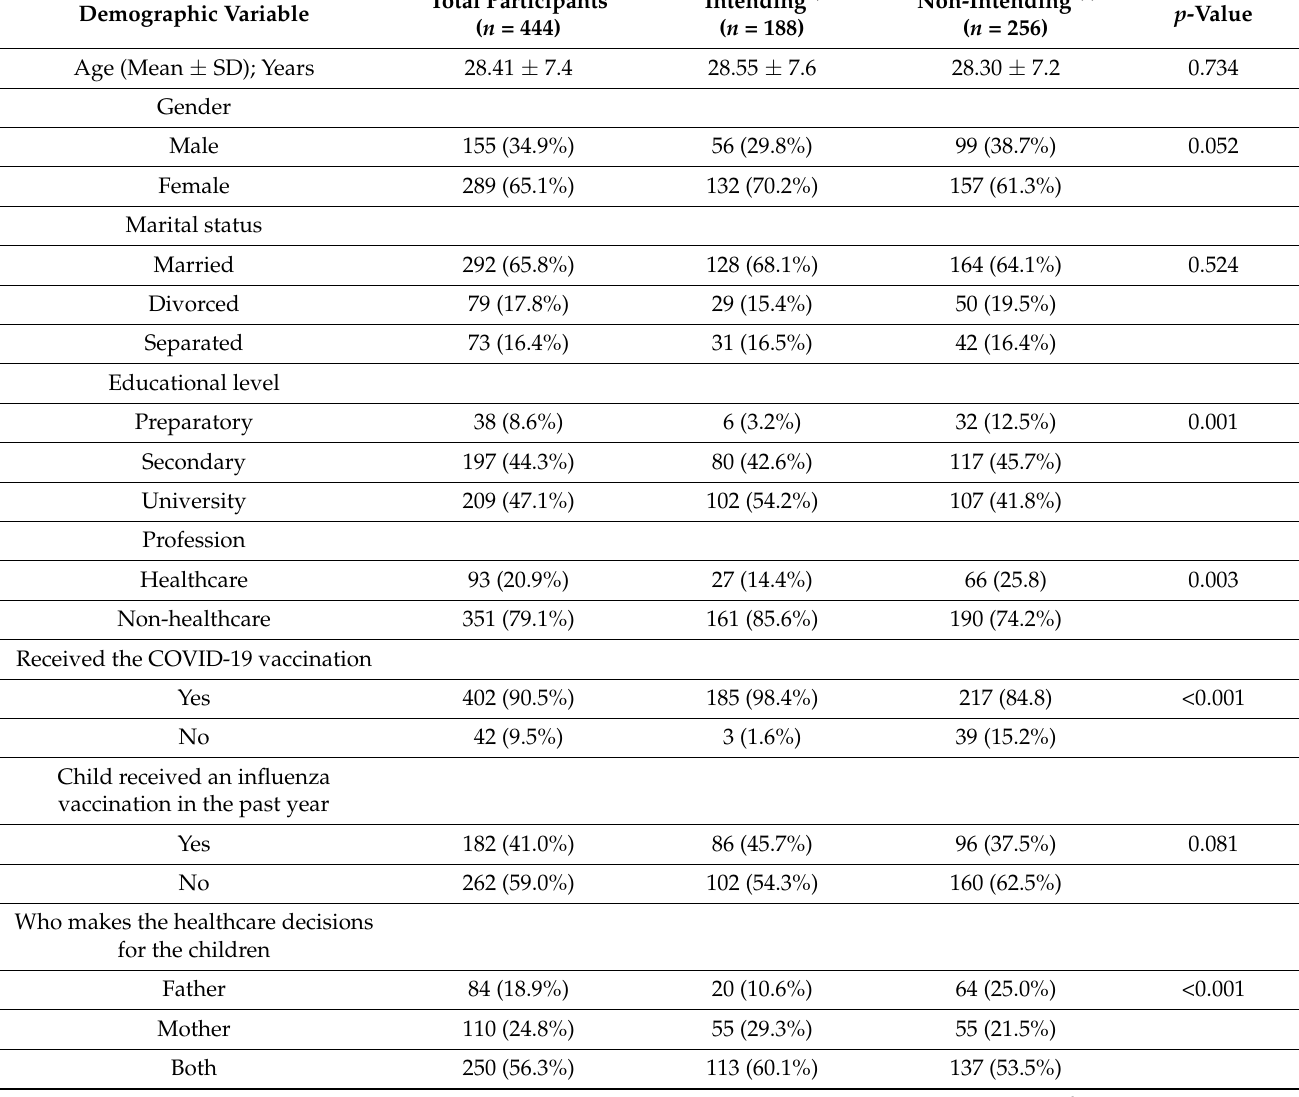
Table 1. Demographic features of parents included in this